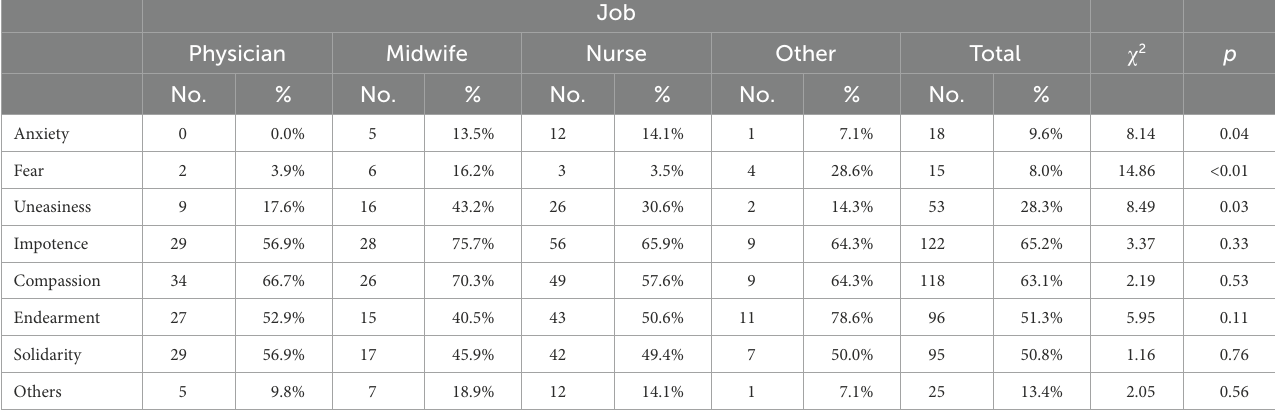
TABLE 2 Emotions most frequently reported when assisting parents’ meeting with their dead baby.